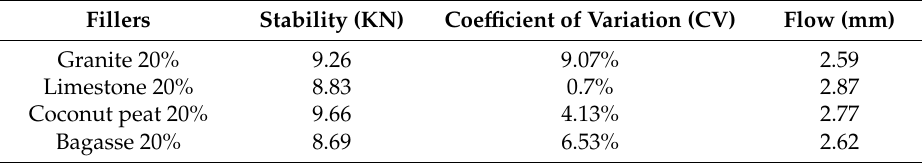
Table 7. Result of Marshall stability and flow test (not considered mastic viscosity).